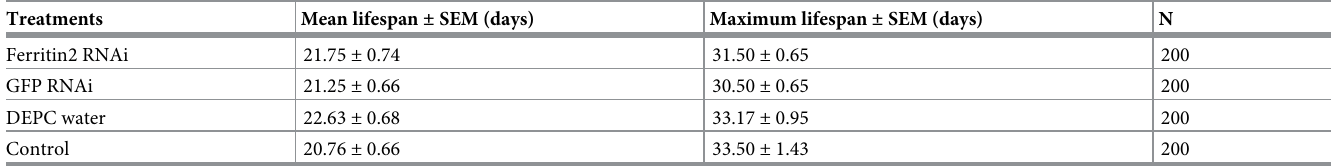
Table 1. Mean and maximum lifespan of worker bees of ferritin2 RNAi, GFP RNAi, DEPC water, and control.